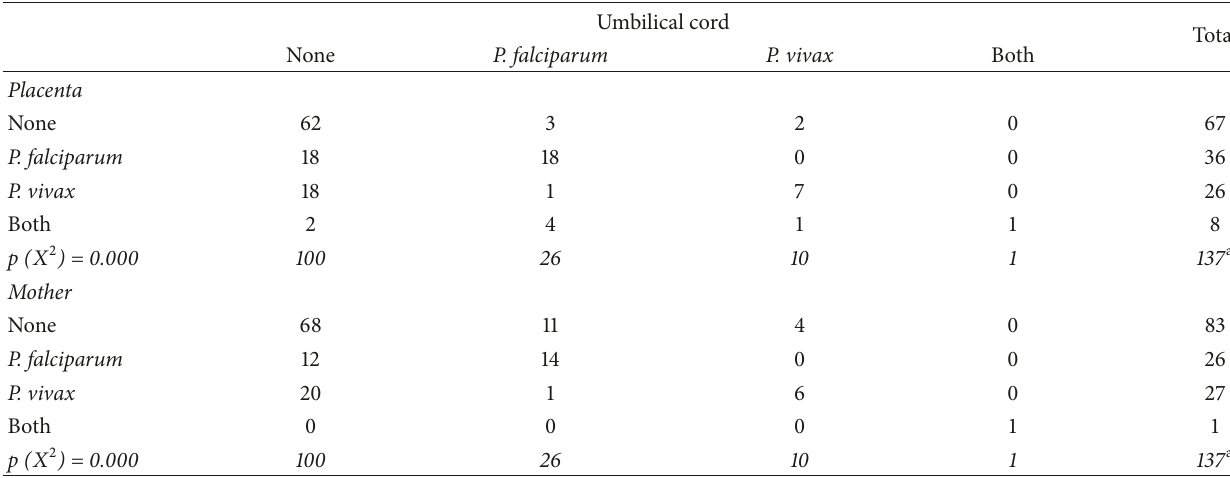
Table 3: Plasmodial species detected by qPCR in maternal and placental blood of 37 cases with plasmodial DNA in umbilical cord. (a) In cord-placental blood and cord-maternal blood